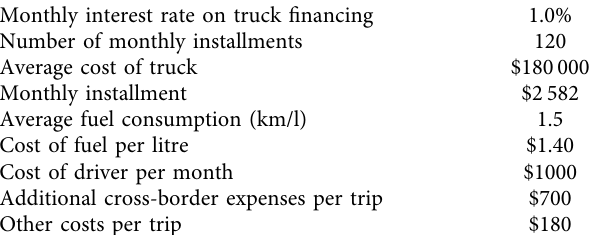
Table 1: Direct transport cost parameters.